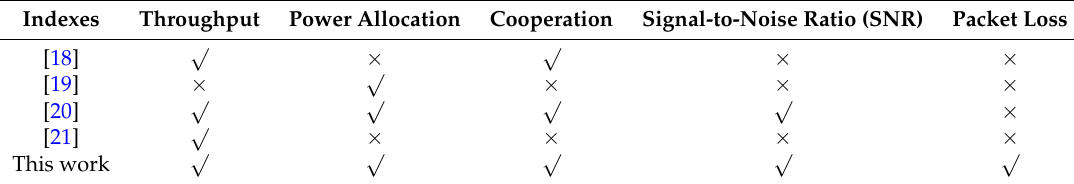
Table 1. Differences of the proposed work with the